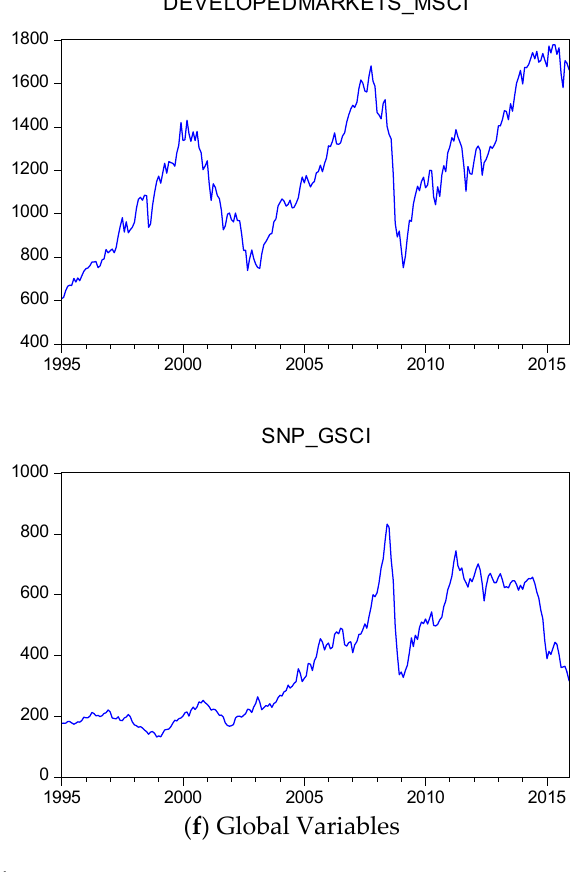
Figure A1. Times series plot of data.